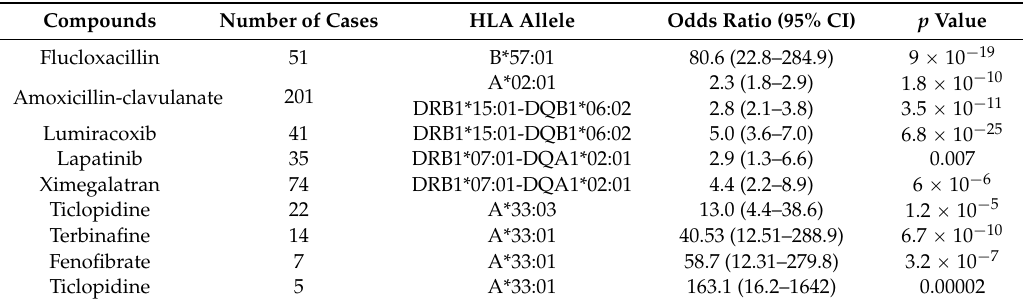
Table 5. HLA alelles associated to hepatotoxicity.